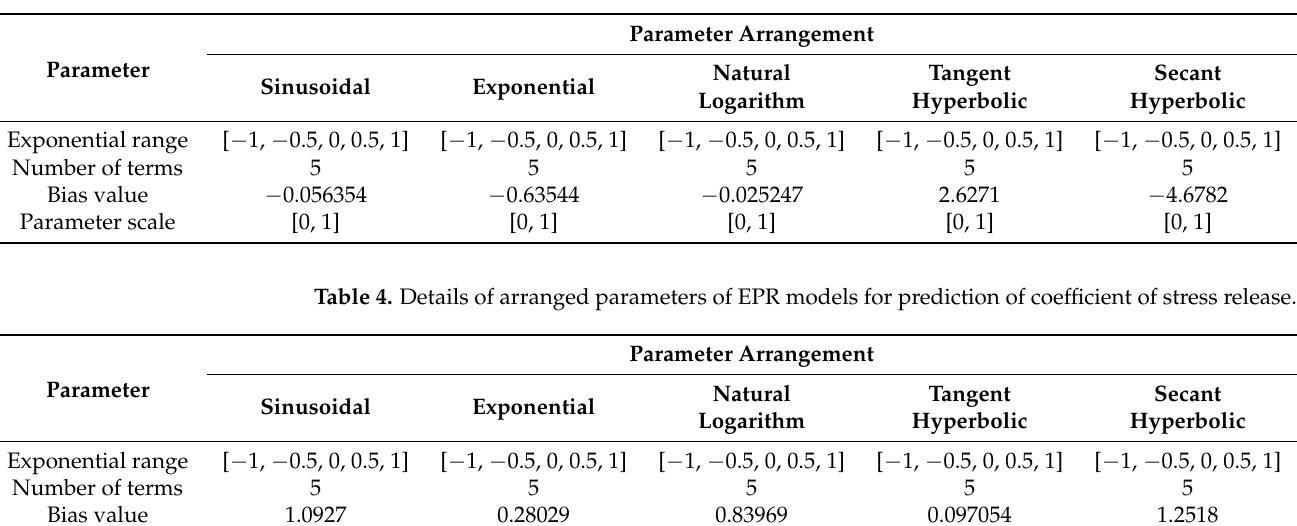
Table 3. Details of arranged parameters of EPR models for prediction of collapse settlement.